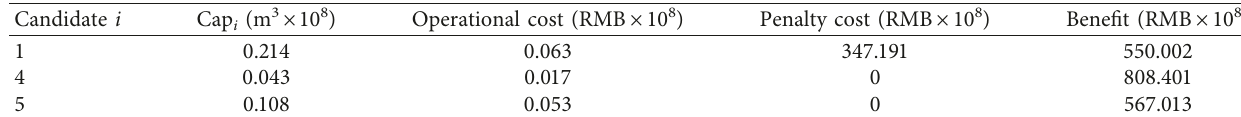
Table 12: Planning decisions and the cost/benefit.